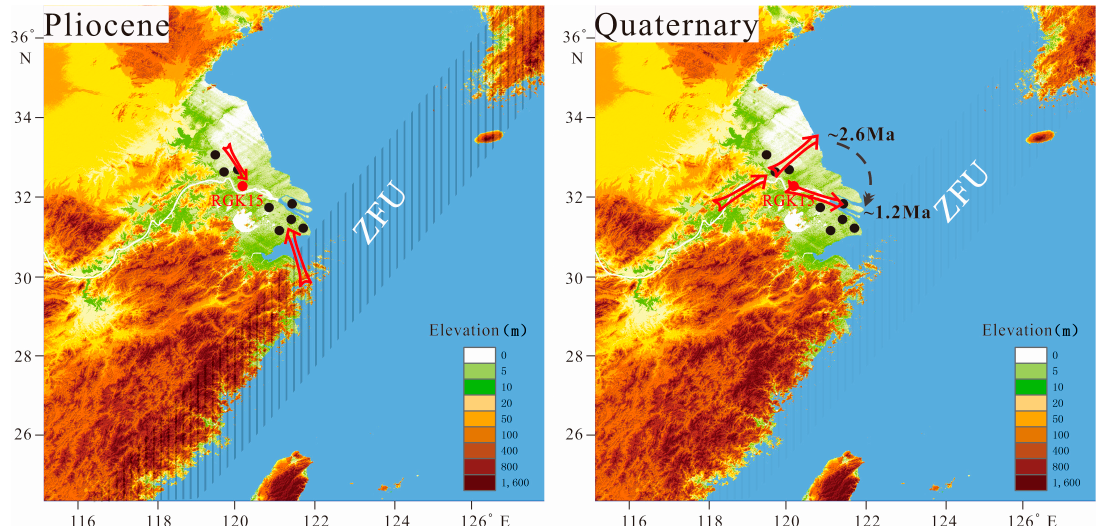
Figure 7. Sediment provenance evolution during the late Cenozoic related to subsidence of the ancient Zhejiang–Fujian Uplift (ZFU) [41,42]. Red arrows represent sediment sources. The black arrow represents the shift of the Yangtze channel with the ZFU subsidence.